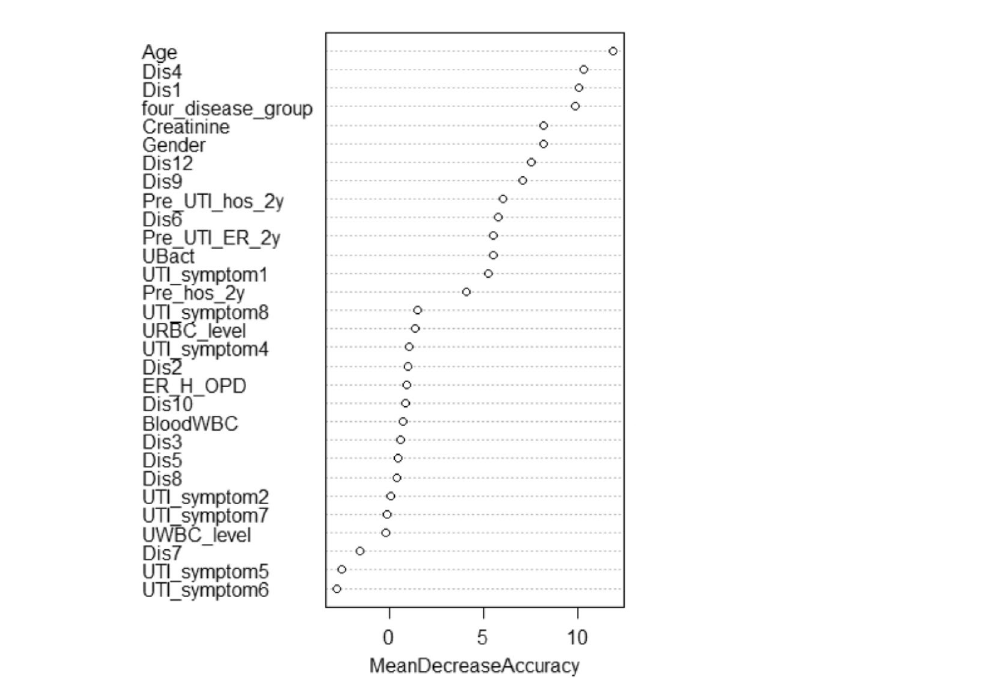
Figure 1. Variable importance plot of the first stage RF analysis in percentage of mean decrease accuracy for the factors. It shows that age, cirrhosis (Dis4), diabetes mellitus (Dis1), and disease group (four_disease_group) are the most important 4 factors to predict recurrence in the clinical visit (sample size =